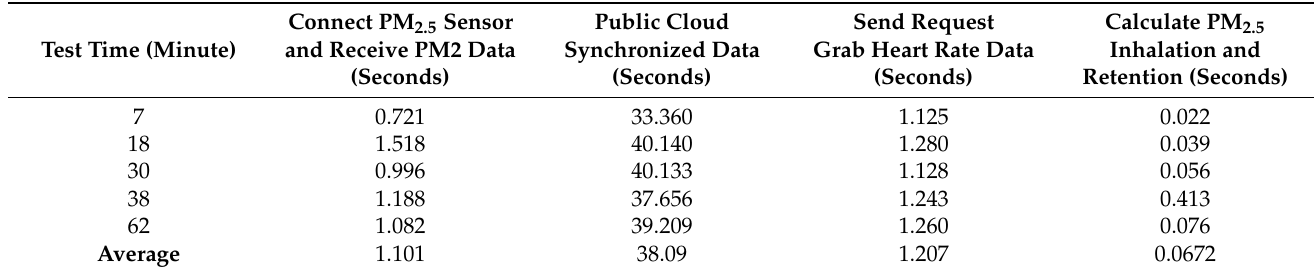
Table 2. System execution time.